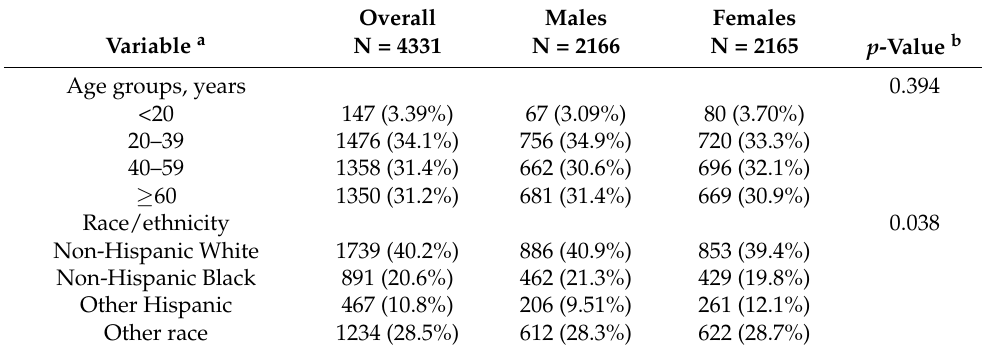
Table 1. Characteristics of study population (NHANES,